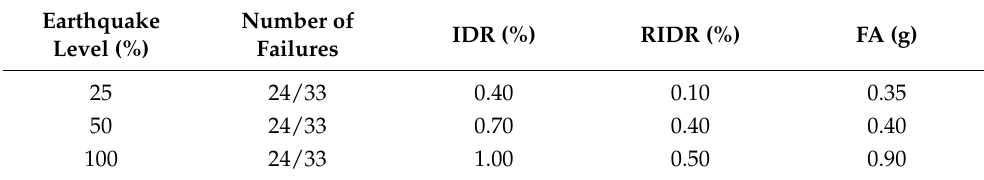
Table 9. Number of failures and peak IDR, RDIR, FA values (no seesaw, flexural hinges). Earthquake Level (%)